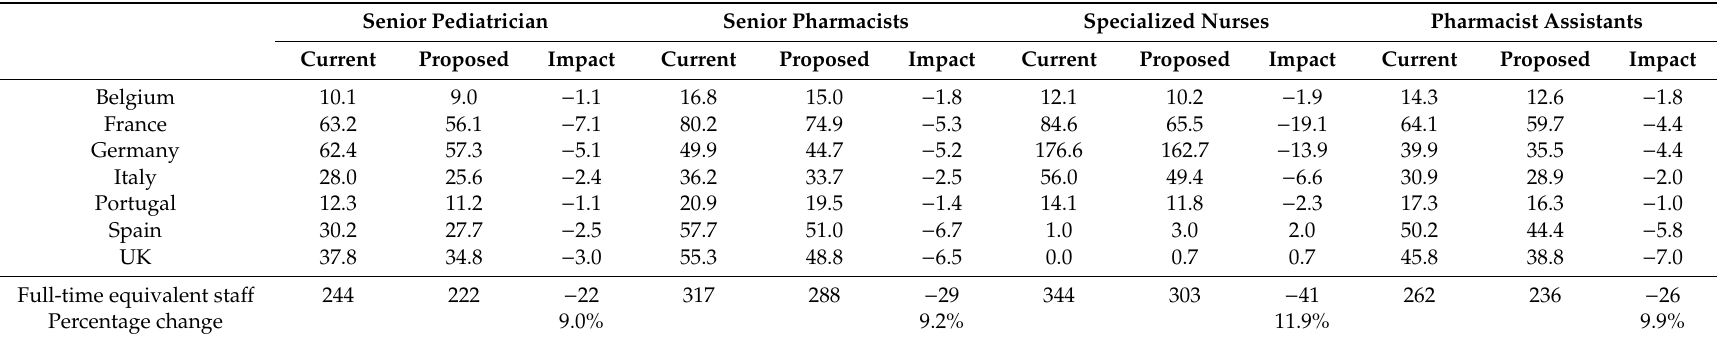
Table 3. Estimated national e ff ects of a 10 percentage point increased use of ready-to-use 3CBs on annual numbers of full-time equivalent * hospital sta ff spending time on compounding across di ff erent